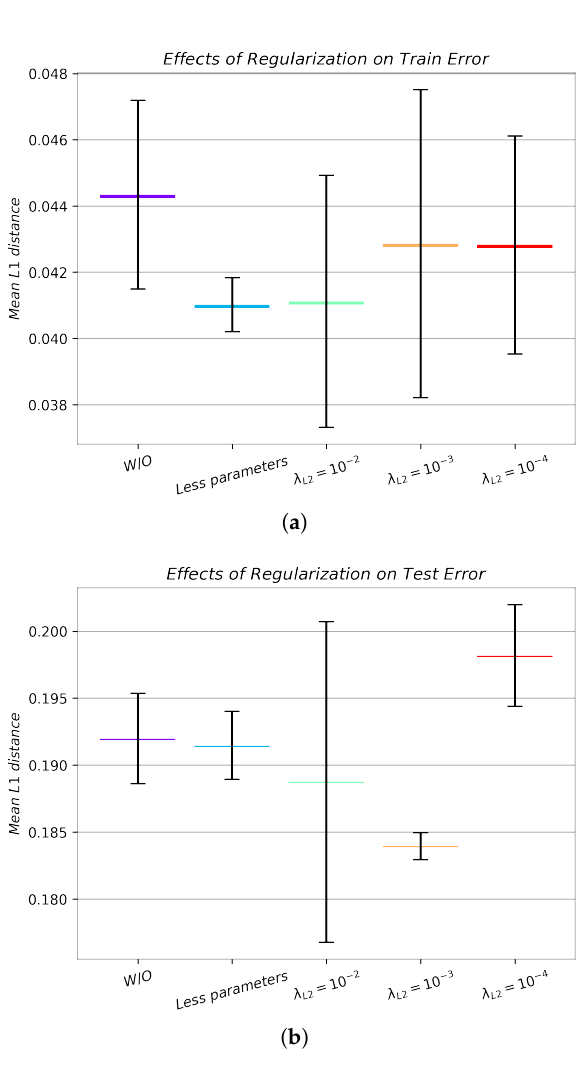
Figure 12. Quantitative effects of no regularization (W/O), L2 regularization ( λ L 2 ) and diminished capacity (Less parameters) on train and test error of the normalized to [ − 1,1 ] satellite-imagery dataset. Absolute metrics can be seen in Table 2. All metrics represent distances in that range. Note that, due to resource constraints, we a priori reduce the capacity of all the models presented above, and no data augmentation (Section 2.8) is used. For more representative results of the unregularized model, refer to Figure 8. ( a ) We can see that, almost surprisingly, the training errors of the regularized models are on average better that the unregularized one, though all their ranges overlap. ( b ) We can observe statistically significant improvement of the error of some regularized models over the plain model. Note the large gap (variance) still in train and test performance, indicating overfitting. 2000 samples are used to calculate test